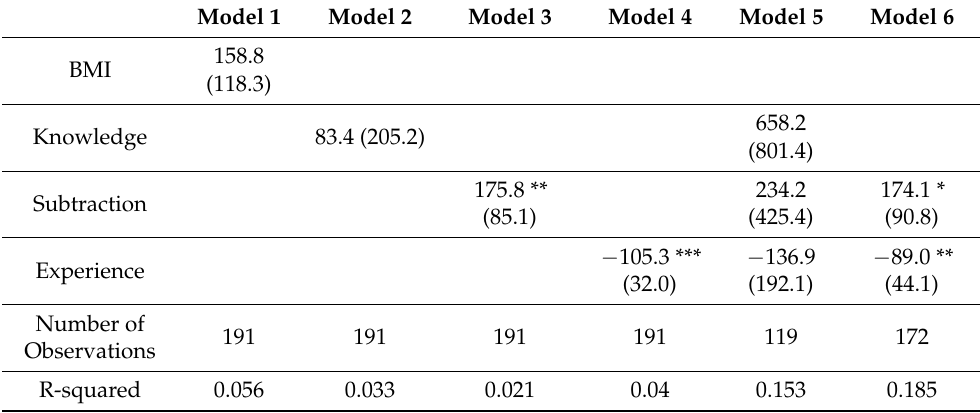
Table 7. Nonparametric regressions: Y = Transaction Costs (N =